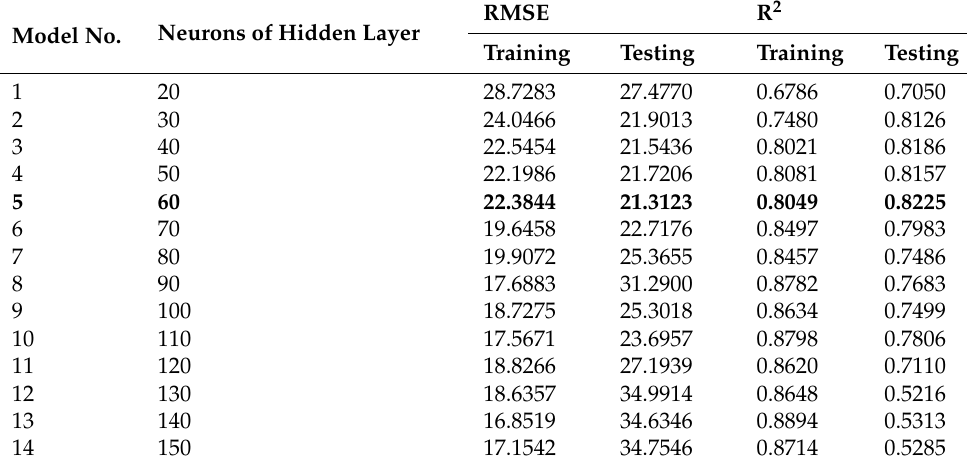
Table 2. Performance evaluation of ELM models with different number of neurons in the hidden layer. Model No.